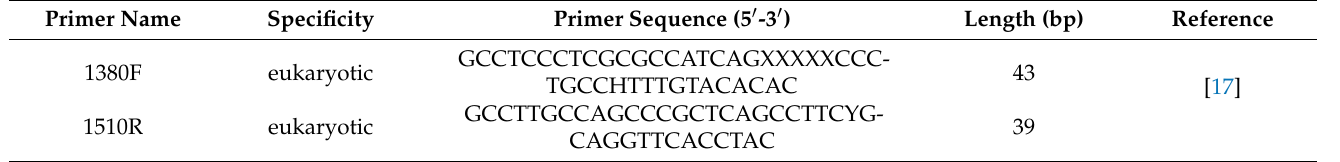
Table 1. Oligonucleotide primer sequences with adapter regions (highlighted in bold) used to amplify the V9 18S rRNA gene of eukaryotic content from the Polypedilum larvae gut